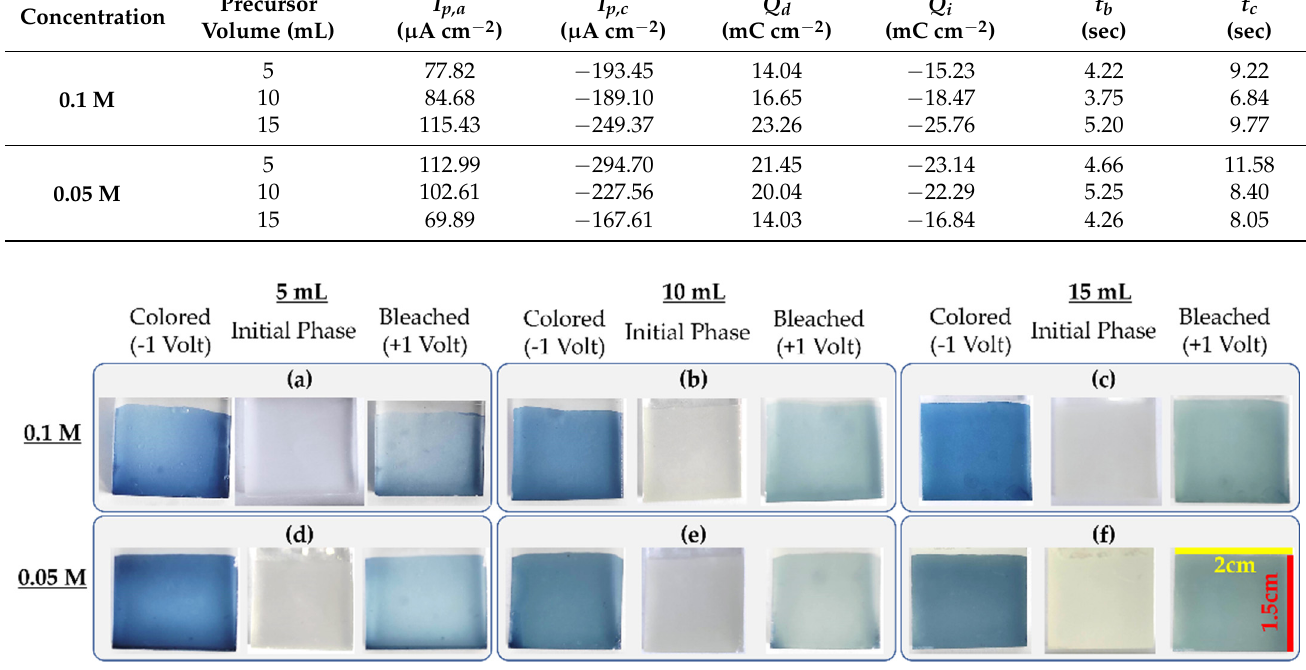
Figure 2. Color shades of the initial, bleached and colored state of the WO 3 coatings with an active area of 2 cm × 1.5 cm: ( a ) 5 mL with 0.1 M; ( b ) 10 mL with 0.1 M; ( c ) 15 mL with 0.1 M; ( d ) 5 mL with 0.05 M; ( e ) 10 mL with 0.05 M; ( f ) 15 mL with 0.05 M. Table 1. Electrochemical properties of WO 3 films.